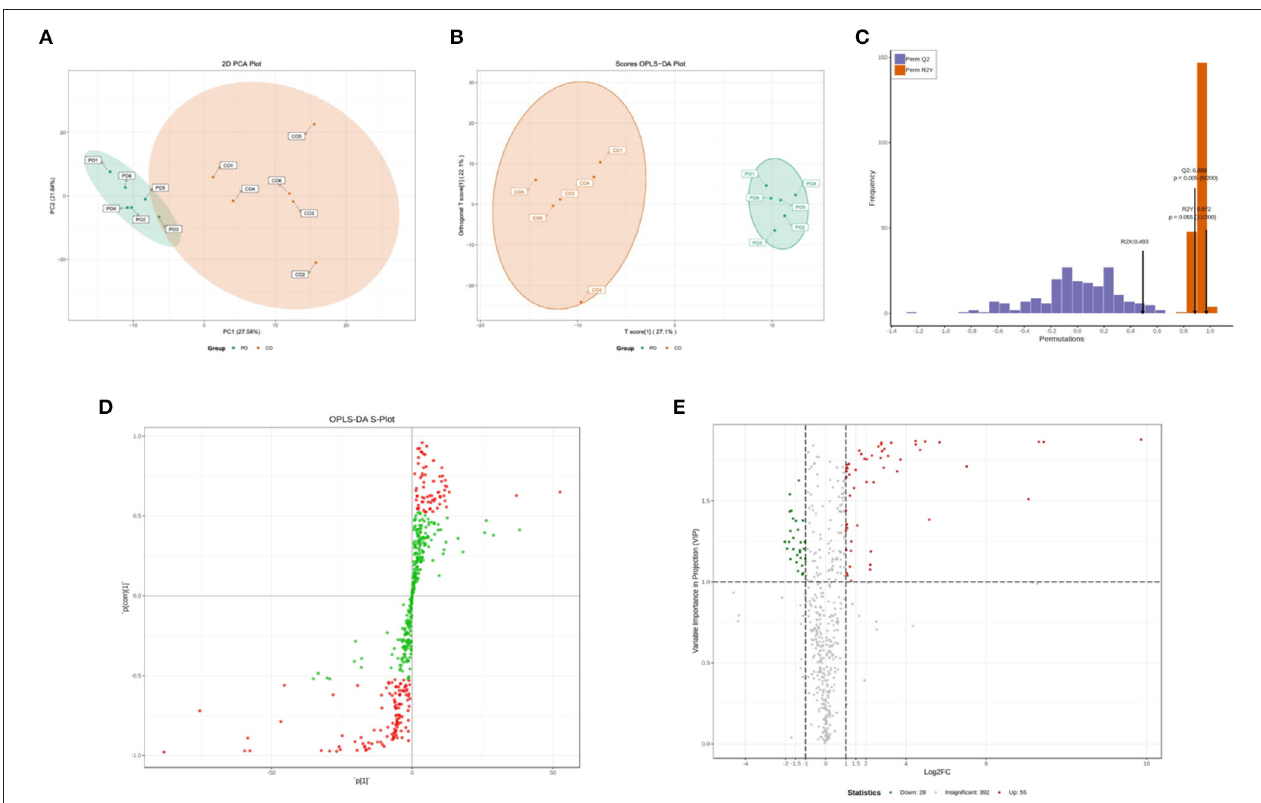
FIGURE 1 | Qualitative and quantitative analysis of the metabolomics data. (A) Principal component analysis (PCA) of metabolomics. (B) Orthogonal partial least squares discriminant analysis (OPLS-DA) scores. (C) OPLS-DA model validation. (D) Variable importance in projection (VIP) values, the metabolites closer to the upper right and lower left corner indicate their more significant differences. Red dots indicate VIP values ≥ 1 for these metabolites, and green dots indicate VIP values < 1 for these metabolites. (E) Volcano plots of all identified metabolites, each point in the volcano plot represents a metabolite. Green dots in the plot represent down-regulated differentially expressed metabolites, red dots represent up-regulated differentially expressed metabolites, and black represents metabolites detected but with insignificant differences. The X-axis represents the logarithmic value of the quantitative difference multiples of a metabolite in two samples; the Y-axis represents the VIP